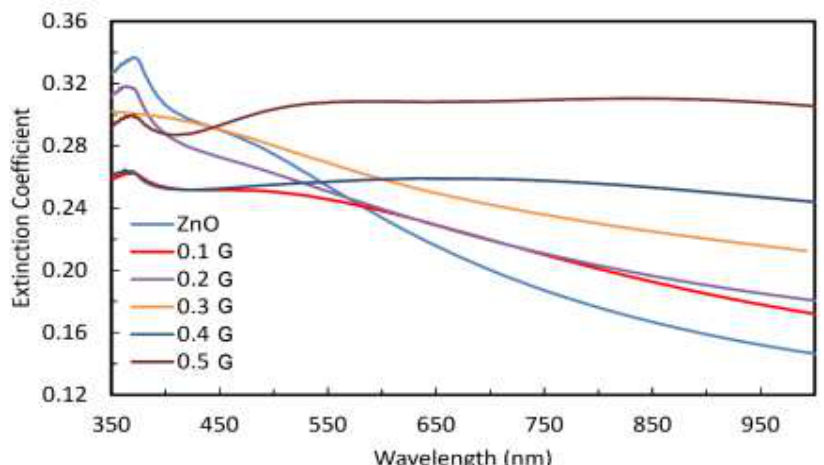
Figure 5: Extinction coefficient spectra of the nanohybrid graphene-ZnO thin films at different concentrations.